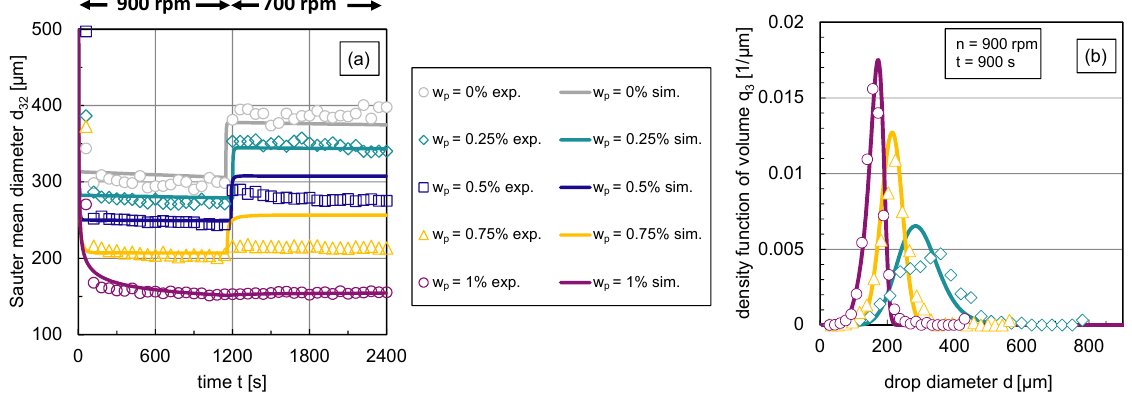
Figure 9. Comparison of experimental and simulation results: Simulations (lines) with the use of the free parameters listed in Table 1 and modified coalescence efficiency (Equation (12)) and experimental data (symbols). ( a ) Transient Sauter mean diameter with a step-wise change in stirrer speed from n = 900 rpm to n = 700 rpm at t = 1160 s, ( b ) stationary density-volume distributions q 3 at n = 900 rpm for particle mass fractions w p = 0.25%, w p = 0.75% and w p =